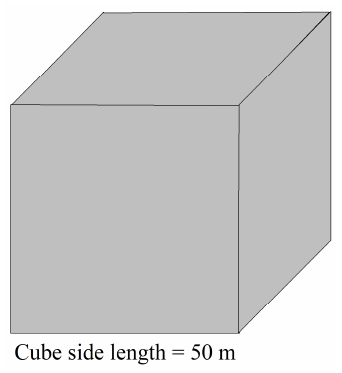
Figure 3. Simulate the shape of an obstacle. Table 2. Data simulation point coordinate parameters.